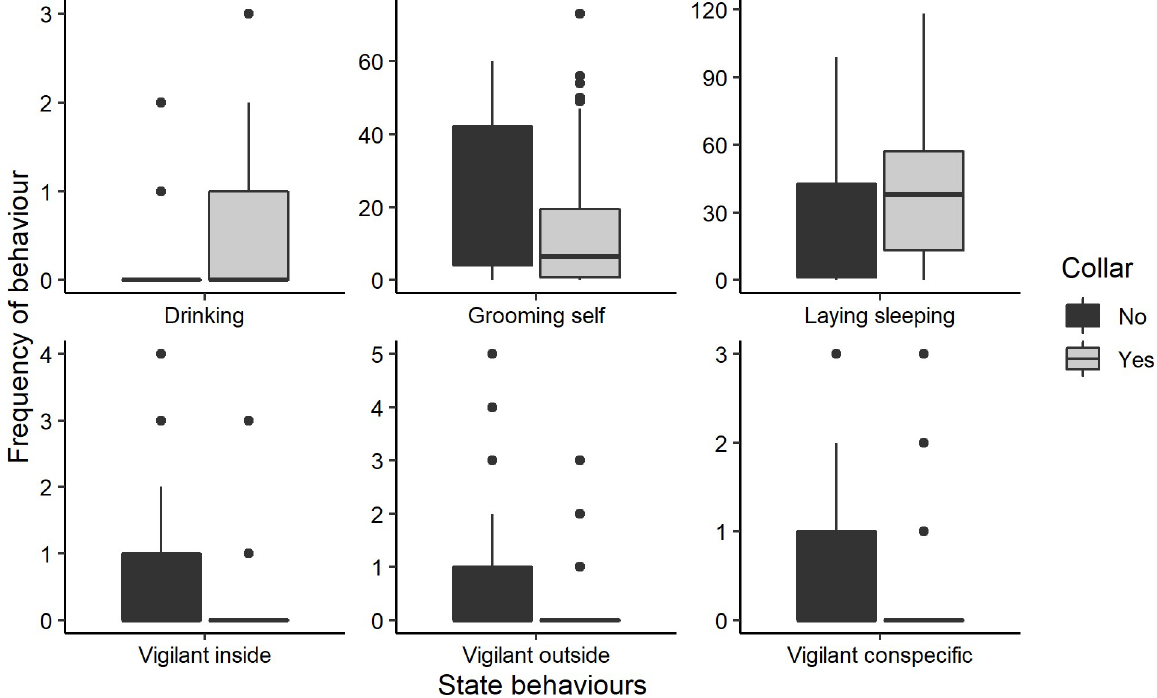
Fig 6. Significant differences between the frequency with which inactive and active state behaviours were displayed on a detailed level between the collared and uncollared period. Data for the male and female are pooled, only those behaviours that were displayed by both the male and the female are shown. Vigilant inside = vigilant towards something inside the enclosure, Vigilant outside = vigilant towards something outside the enclosure, Vigilant conspecific = vigilant toward